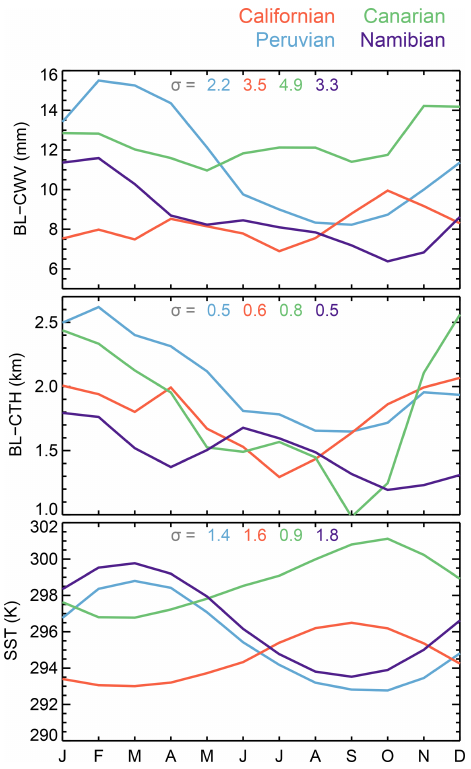
Figure 9. Seasonal cycle of BL-CWV, BL-CTH, and SST, for the regions delimited in Fig. 6 by the rectangular boxes. The numbers shown are the average standard deviation per region. Table 2. Climatological (top) and interannual (bottom) correlation coefficients between BL-CWV and several other variables. Bold text indicates a high correlation coefficient ( | r | > 0 .